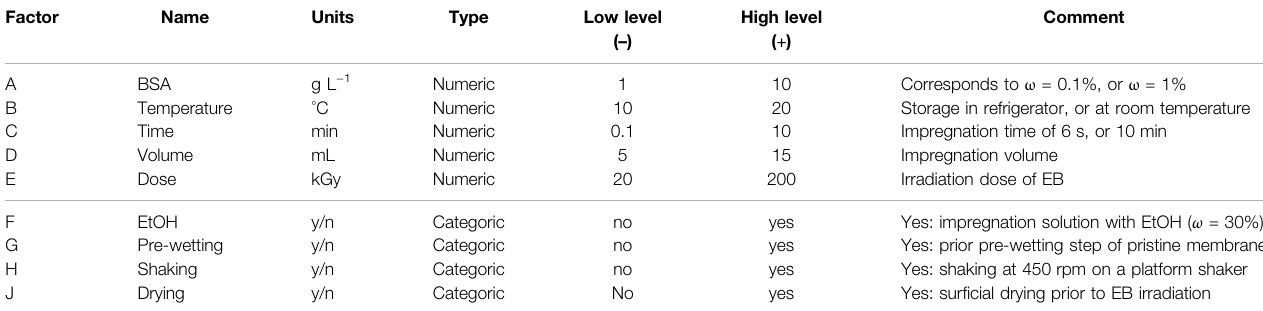
TABLE 2 | Investigated nine process factors by using a MR5 characterization design. Factors can be divided in numerical and categoric types (here: presence or absence, yesorno).Givenarethefactorsimpli fi ednames(see Table1 ),units,andeachalowfactorlevel(codedas – ),andahighfactorlevel(codedas+),respectively.Thefactor levels were chosen to cover a practical range of common settings of this EB processing method. The MR5 design resulted in 46 experimental runs.